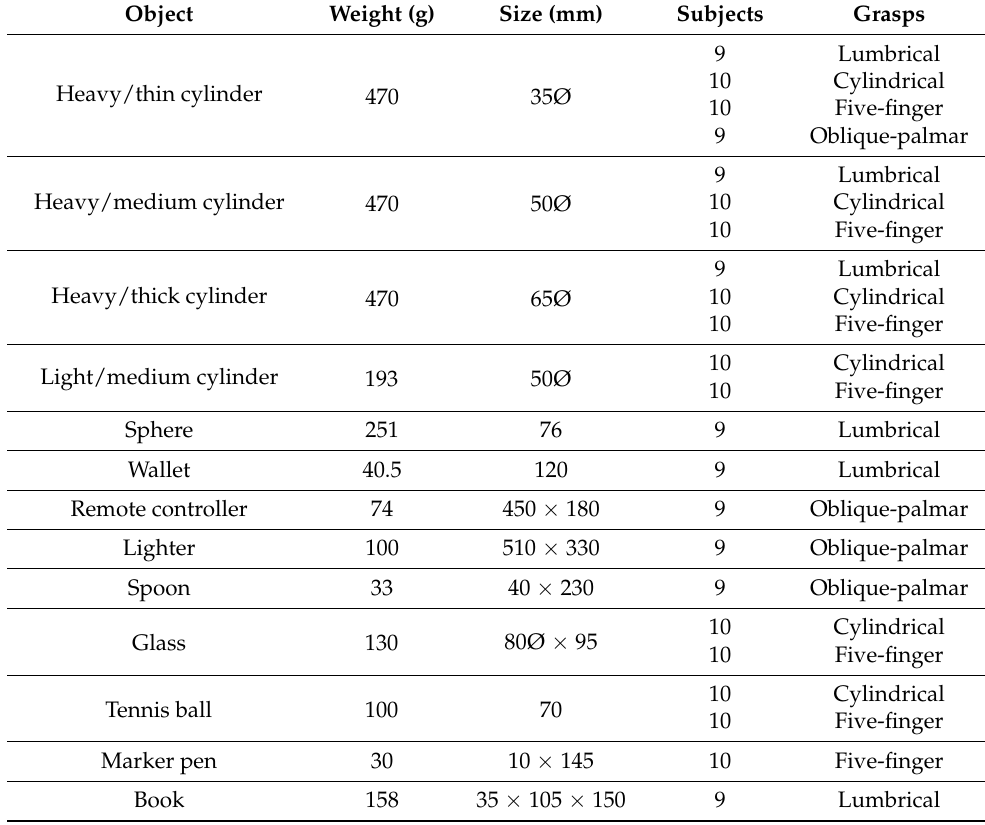
Figure 1. Top: ( a ) starting posture; ( b ) final and initial posture of the hand (A) on the table, and initial (B) and final (C) positions of the object. Bottom: Lumbrical grasp ( c ), Oblique-palmar grasp ( d ), Five-finger grasp ( e ), and Cylindrical grasp ( f ). Table 1. Objects, properties (weight in grams (g) and size in millimeters (mm)), subjects and types of grasps performed during the postures recorded in the